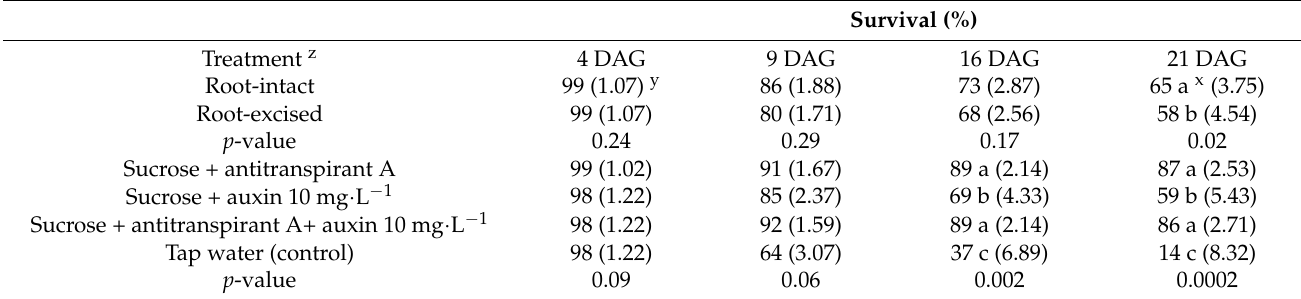
Table 3. Survival (%) of grafted watermelon transplants measured at 4, 9, 16, and 21 days after grafting (DAG) at Mount Vernon, WA. Prior to grafting, rootstock seedlings received applications of sucrose, antitranspirant, and auxin treatments and root-excision from rootstock occurred immediately prior to grafting. Grafting was carried out for trials 1, 2, and 3 on 19 August, 14 October, and 10 November 2020, respectively, and data were combined ( p =